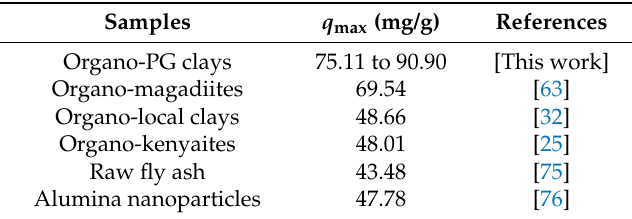
Table 10. Removal capacities of various adsorbents for eosin